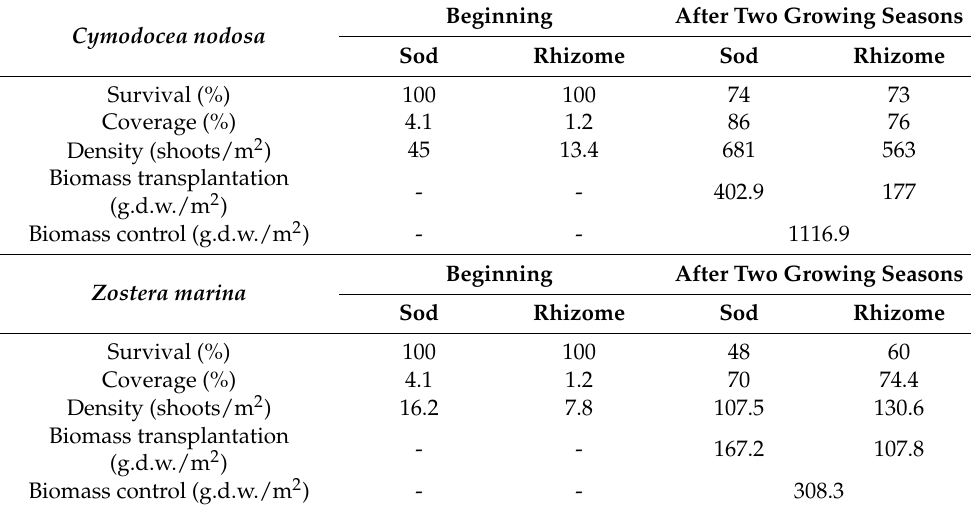
Table 3. Average values of parameters monitored for C. nodosa and Z. marina [50]. Cymodocea